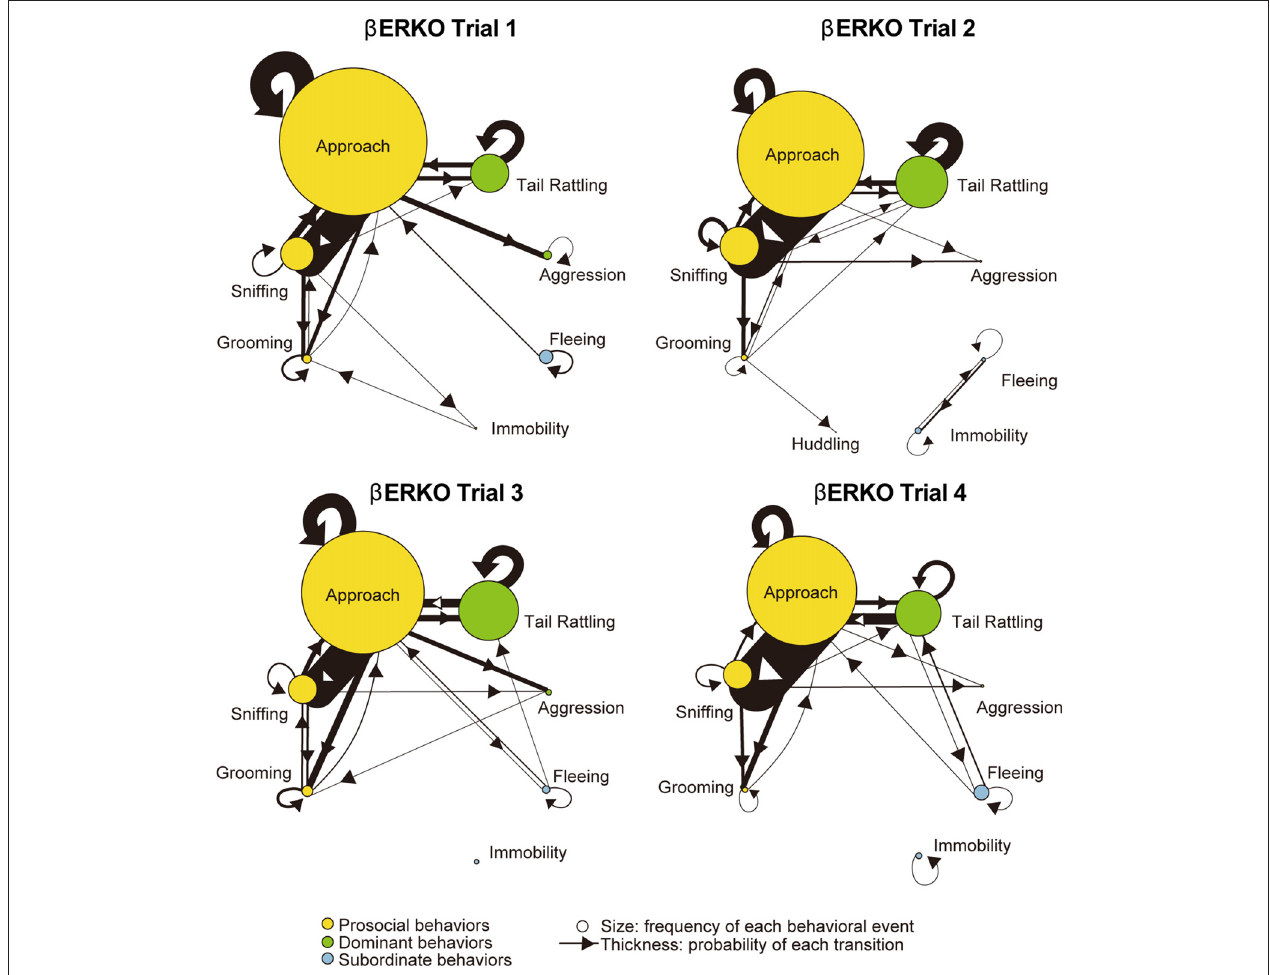
FIGURE 4 | Kinetograms for monad behavioral transitions β ERKO mice in each trial.The diameters of circles were calculated for each genotype and trial using the following formula. Circle diameter is proportional to (Total number of each behavioral event)/(Total number of all behavioral events within each genotype and trial). Type of behavioral events (prosocial, dominant or subordinate) were indicated by circle color. Width of the arrows were also calculated using the following formula. Arrow width is proportional to (Total number of each transition)/(Total number of all transitions within each genotype and trial). Arrowhead indicates direction of each transition.